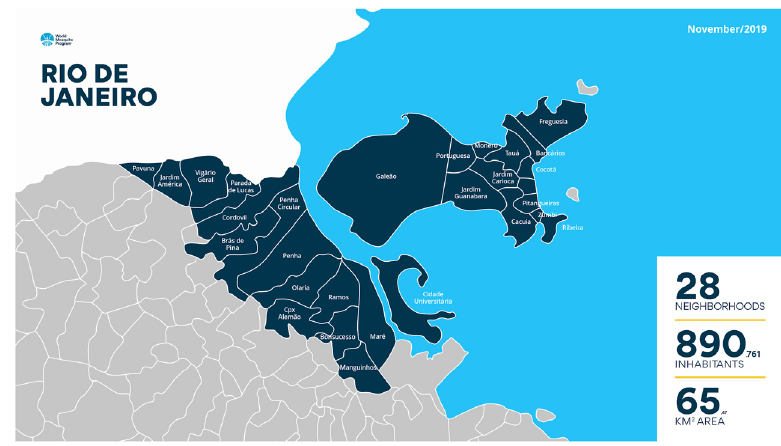
Figure 2. World Mosquito Program (WMP) Brazil’s release area at Rio de